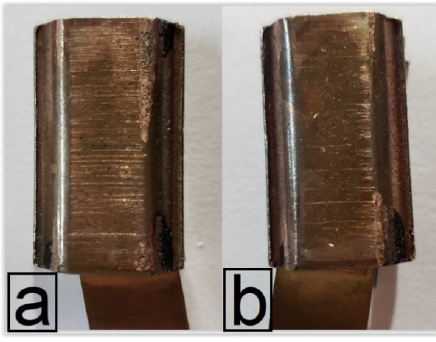
Figure 12. Worn mobile contacts after period in operation on the regulator—( a ) (Contact a) and ( b ) (Contact b).